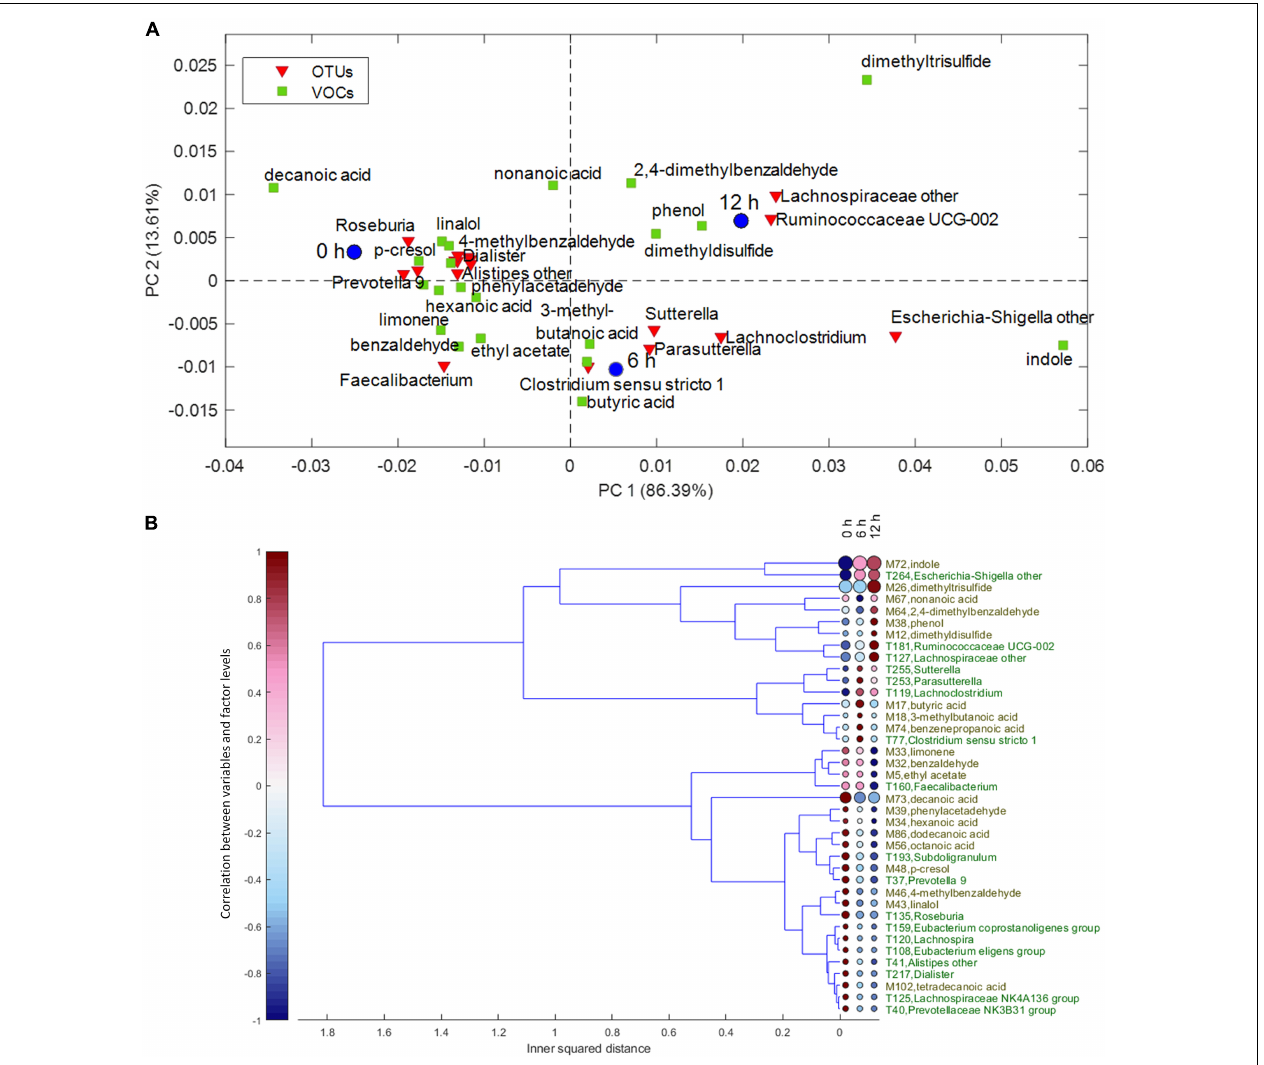
FIGURE 3 | (A) Biplot of the PCA submodel of time effect matrix, where only the selected variables are displayed. (B) Dendrogram of time effect matrix, where for each variable the size of the circles reflects its importance for the submodel, while colors of the circles represent the correlations between the variable and each level of time factor. PCA, principal component